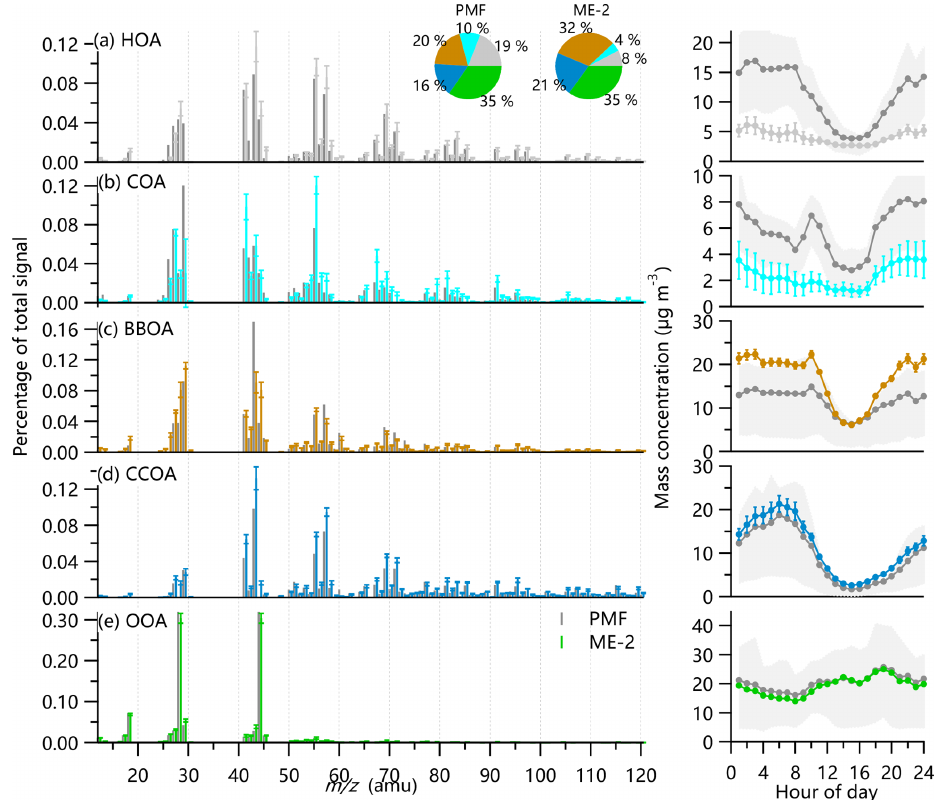
Figure 7. Comparisons of mass spectral profiles, diurnal cycles, and compositions of five OA factors between PMF and ME-2 analysis at a rural site in the North China Plain in winter. The ME-2 results are the averages with an α -value ranging from 0 to 0.3, and the error bars are 1 standard deviation. The shaded areas in the right panel indicate the 25th and 75th percentiles of PMF